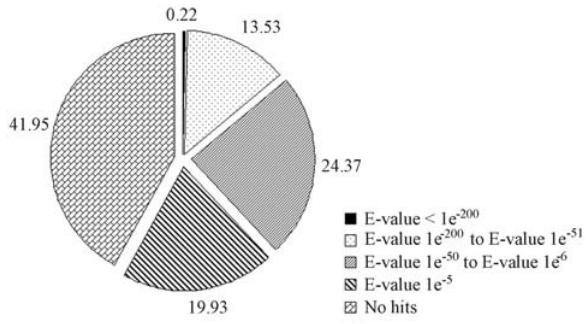
Figure 2 - Frequency of the distribution, in percentages, of P. parasitica/ CitEST ESTs, based on E-value from BLASTX